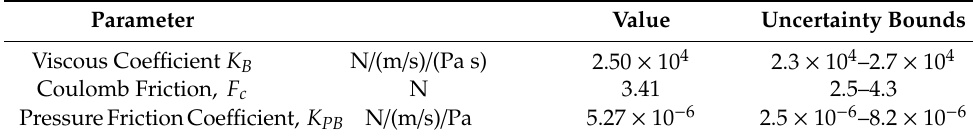
Table 2. Best fit cylinder friction parameters.